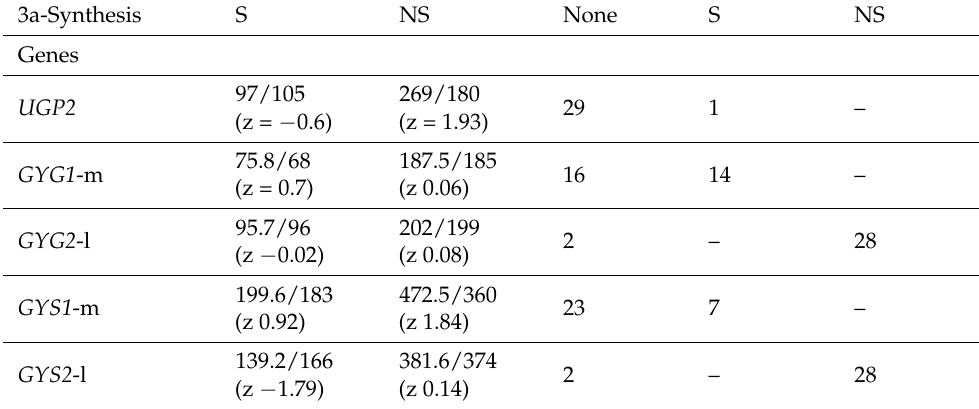
Table 3. a and b: Expected vs. observed (e/o) variants and Z score for synonymous (S) and non- synonymous (NS) variants for genes related to glycogen synthesis and catabolism (from gnomAD), and number of cases with no, synonymous, or non-synonymous variants. When the total num- ber of variants exceeds 30, this implies that some cases carry more than one type of variant (see Tables 4 and